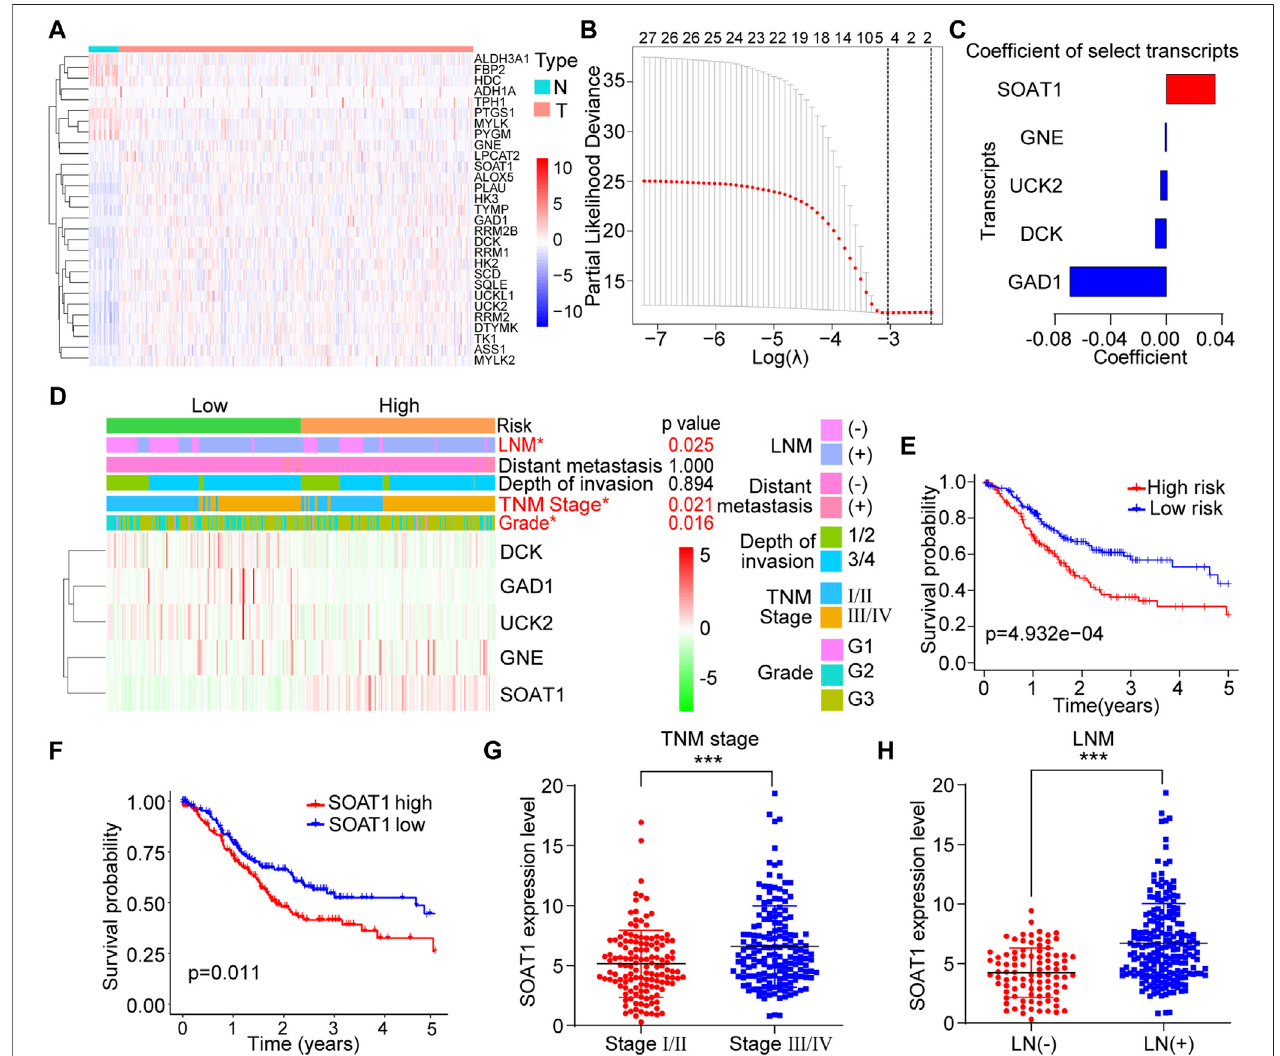
FIGURE 1 | Identi fi cation of SOAT1 as a biomarker in GC from 111 rate-limiting enzymes based on TCGA database. (A) Heatmap of differentially expressed rate- limiting enzymesbetweenGCtumor ( n (cid:1) 375)and normal tissues ( n (cid:1) 32)inTCGA. (B) Thecoef fi cients werecalculated bymultivariateCoxregressionusing theLASSO method. (C) Coef fi cients of the fi ve selected genes. (D) The expression levels of the fi ve selected genes in high- and low-risk GC patients. (E) Kaplan – Meier overall survival (OS) curve for GC patients assigned to the high- and low-risk groups. (F) Kaplan – Meier OS curve of GC patients strati fi ed by SOAT1 expression. (G,H) Correlation of SOAT1 expression with TNM stage (G) and LNM (H) in GC tissues based on TCGA data.